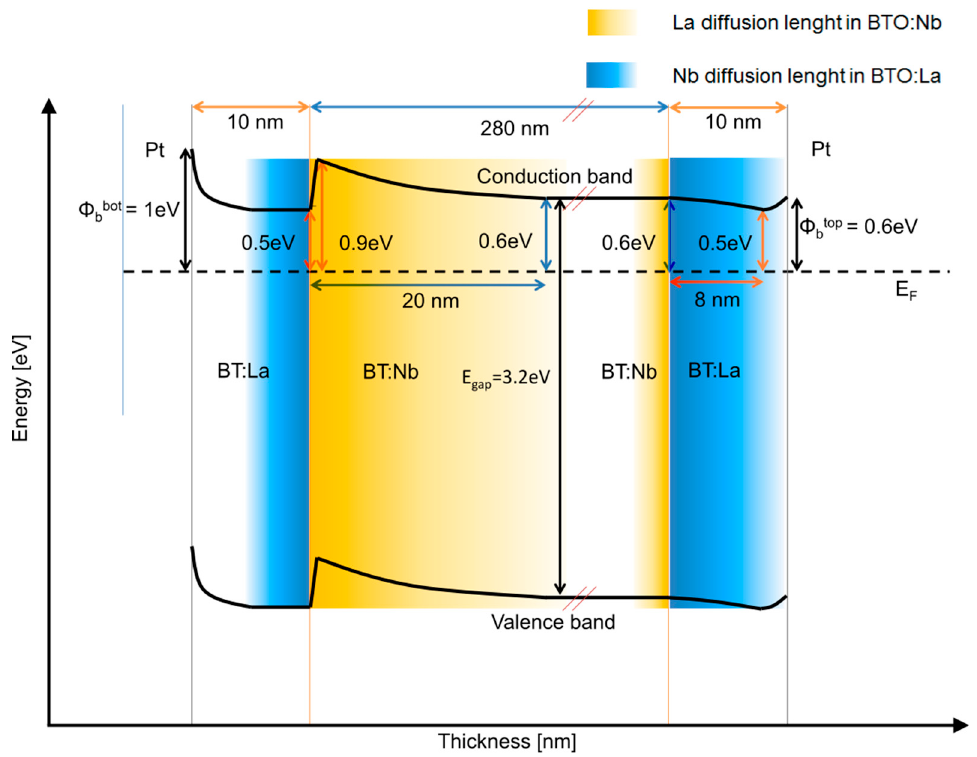
Figure 8. Band diagram of capacitor LNL10 with Pt barrier heights derived from the results of E. Arveux [17].